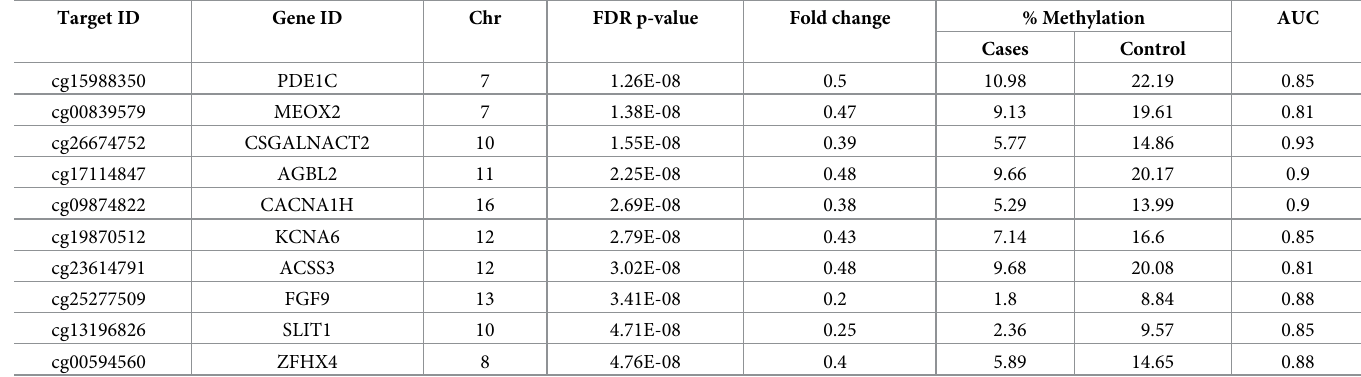
PLOS ONE | https://doi.org/10.1371/journal.pone.0200229 March 21,